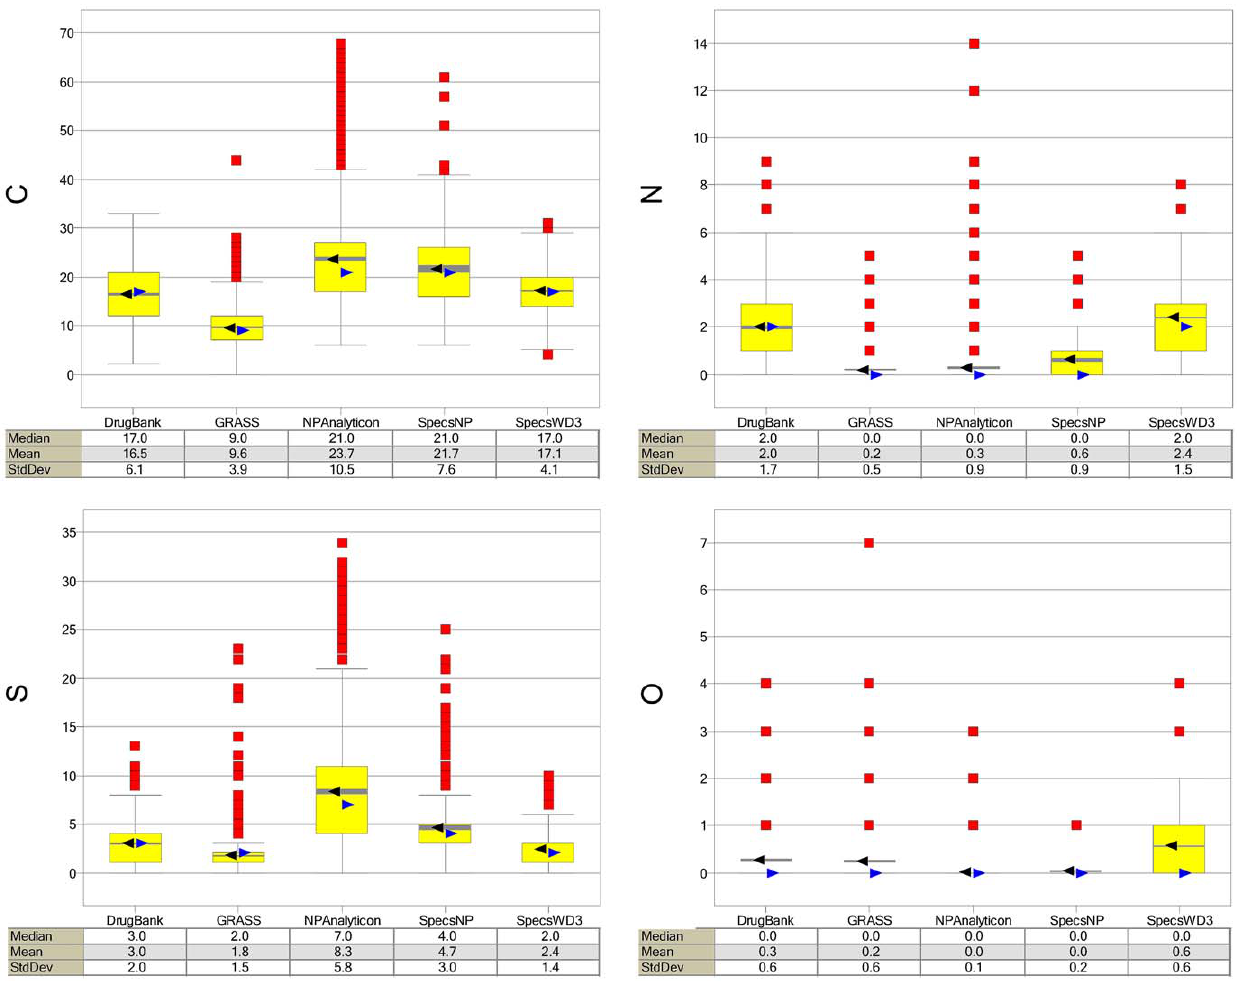
Figure 4. Box-and-whisker plots of atom counts. The symbols and colors in the plots are the same as in Figure 1.